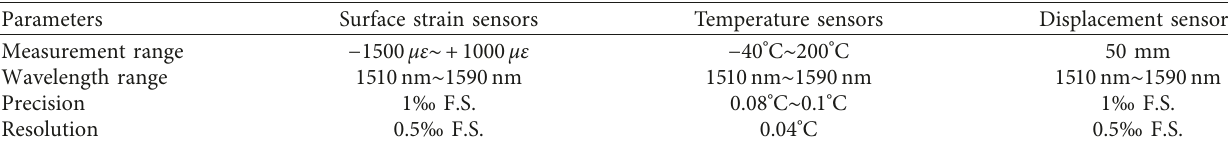
Figure 33: Frequency variation versus time: (a) the 1st modal frequency (longitudinal); (b) the 2nd modal frequency (transverse); and (c) the 4th modal frequency (vertical). Table 2: Properties of surface strain sensors, temperature sensors, and displacement sensors.